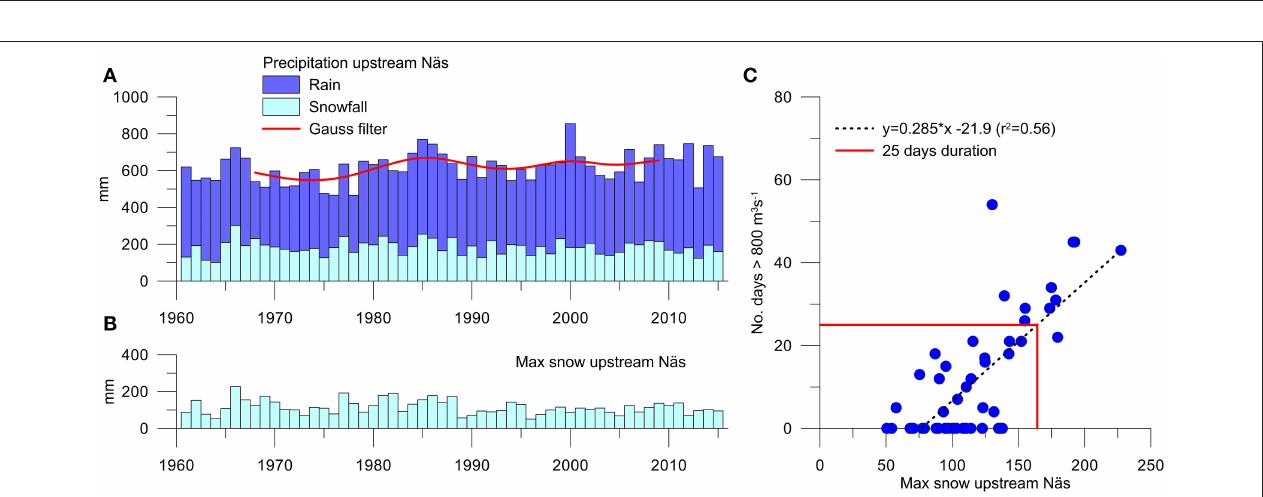
FIGURE 3 | Average water discharge at Näs, using scaled observation from the nearby river gauge at Fäggeby for the period before constructing hydropower dams (purple) and observations at Näs after regulations (black).